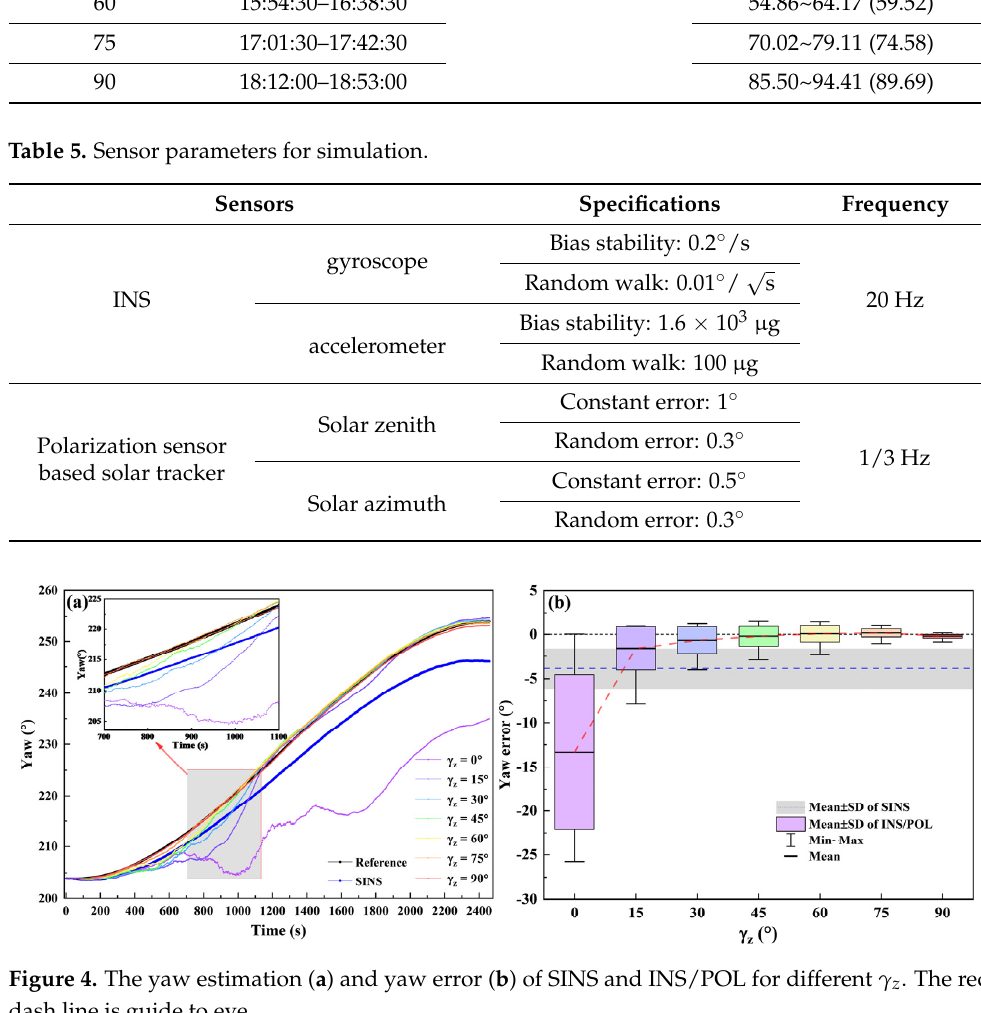
Figure 4. The yaw estimation ( a ) and yaw error ( b ) of SINS and INS/POL for different γ z . The red dash line is guide to eye.